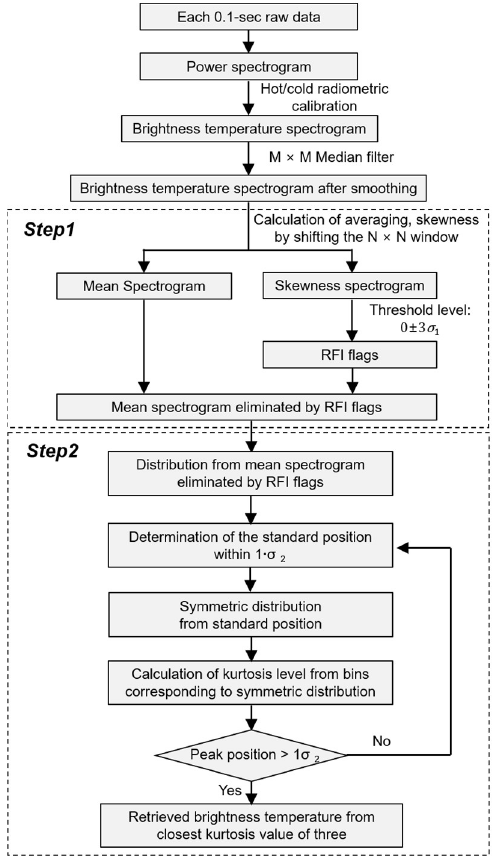
Figure 1. Flowchart of the proposed process.